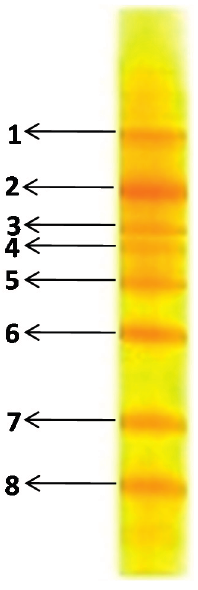
Figure 2. PCR-DGGE profile of microbial